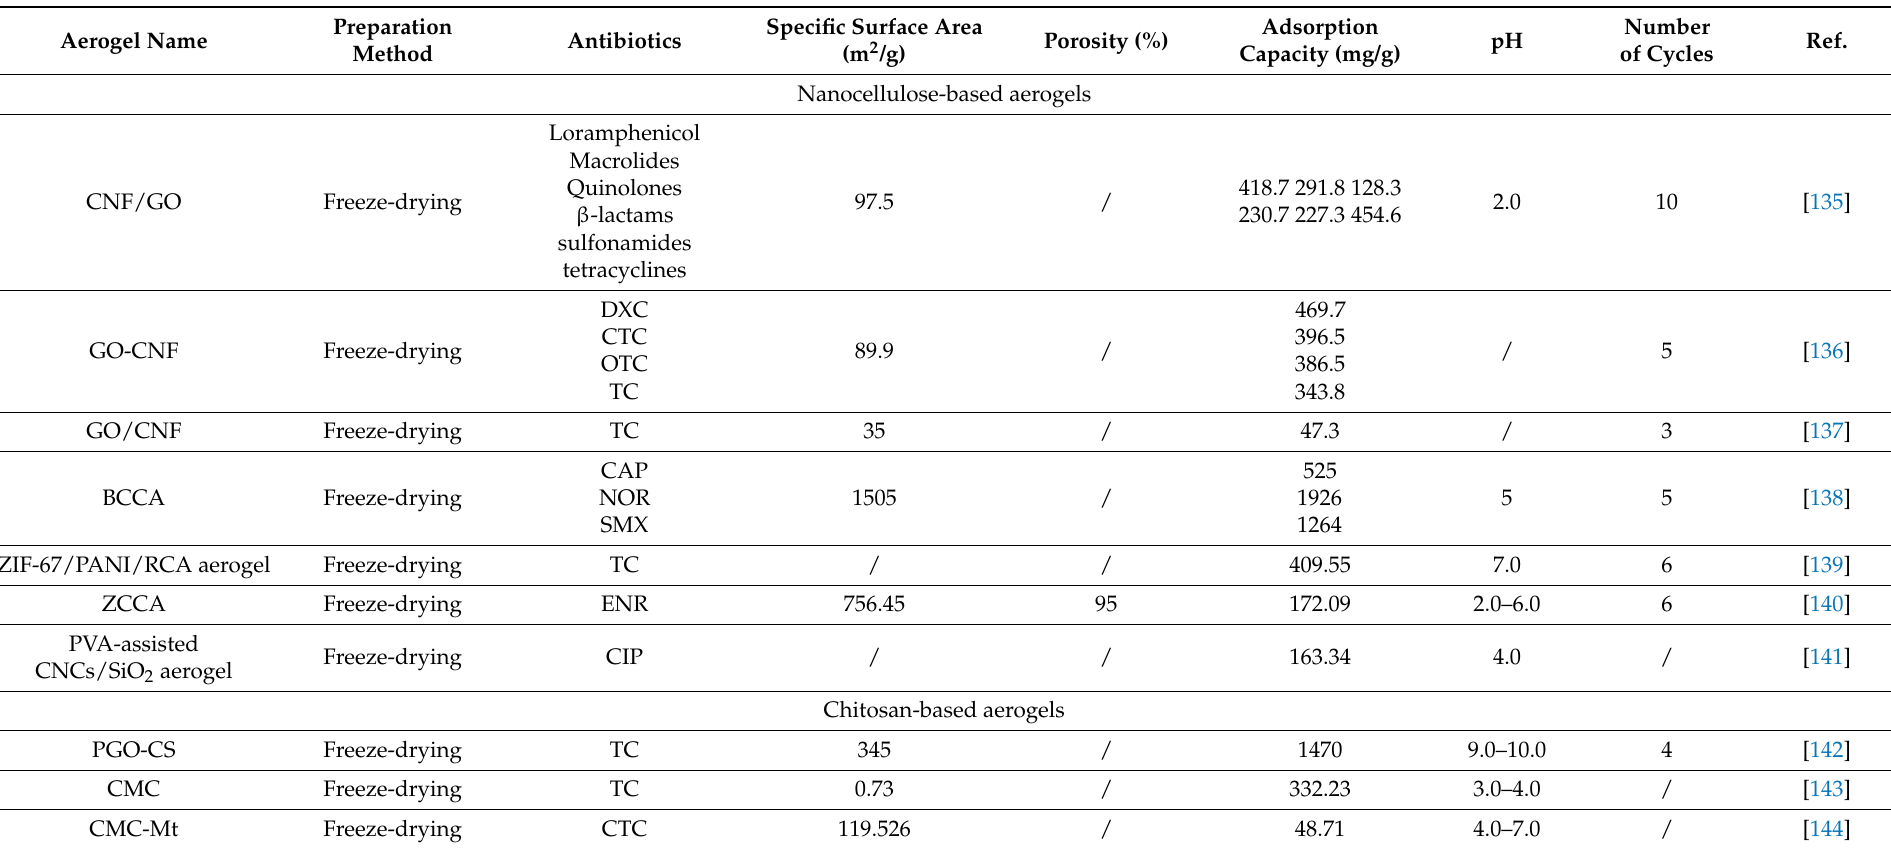
Table 6. Performance of nanocellulose-based aerogels in antibiotic removal compared with chitosan-based aerogels. GO/CNF: GO/nanofibrillated cellulose aerogel; PGO-CS: porous graphene oxide–chitosan aerogel; CMC: carboxymethyl chitosan aerogel; CMC-MT: Na-montmorillonite (Na-Mt) with carboxymethyl chitosan